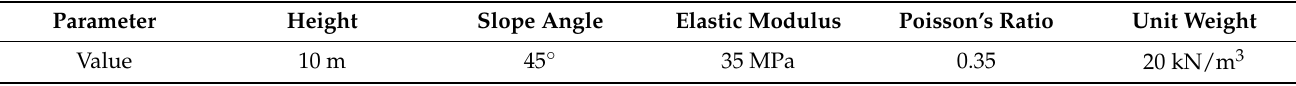
Table 3. The profiles of the assumed soil slope.